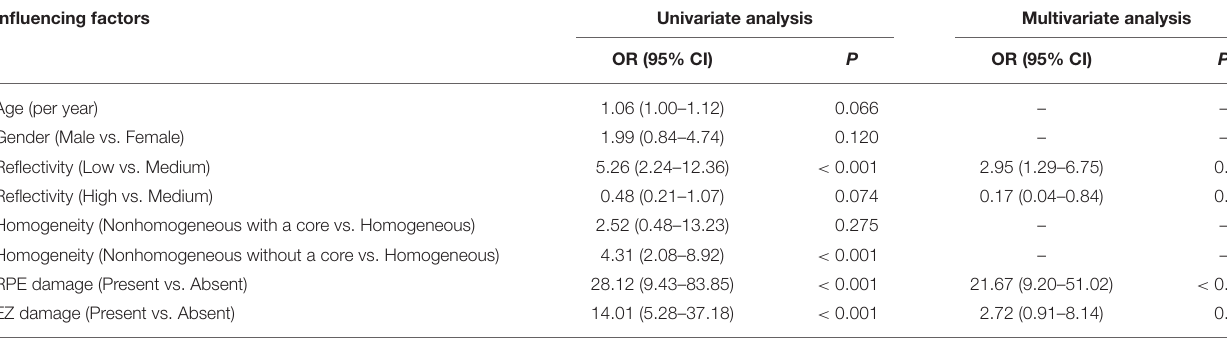
Gender (Male vs. Female) Reflectivity (Low vs. Medium) Reflectivity (High vs. Medium)